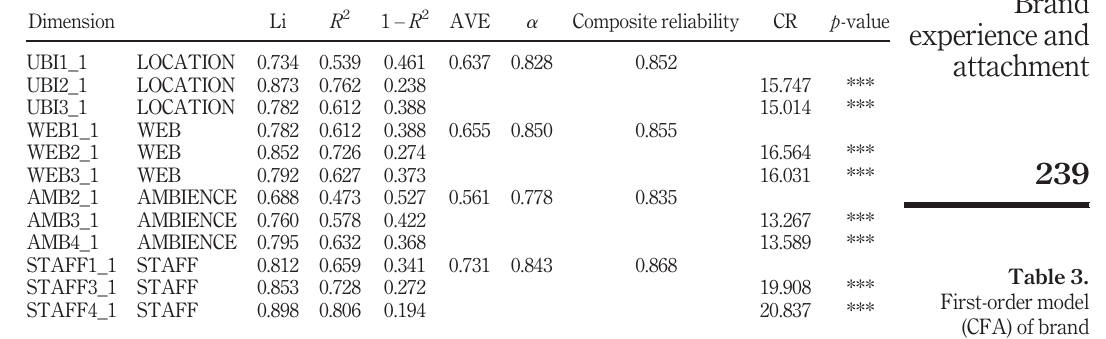
Table 3. First-order